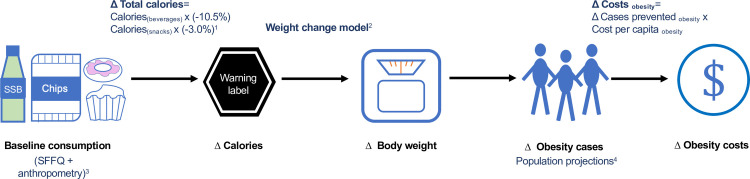
Schematic illustration of the simulation strategy.Sources of information: 1Acton and colleagues, 2019; 2Hall and colleagues, 2011; 3ENSANUT 2016; 4Population projections from CONAPO [10,14–16]. CONAPO, Consejo Nacional de Población; SFFQ, semiquantitative food frequency questionnaire; SSB, sugar-sweetened beverage.